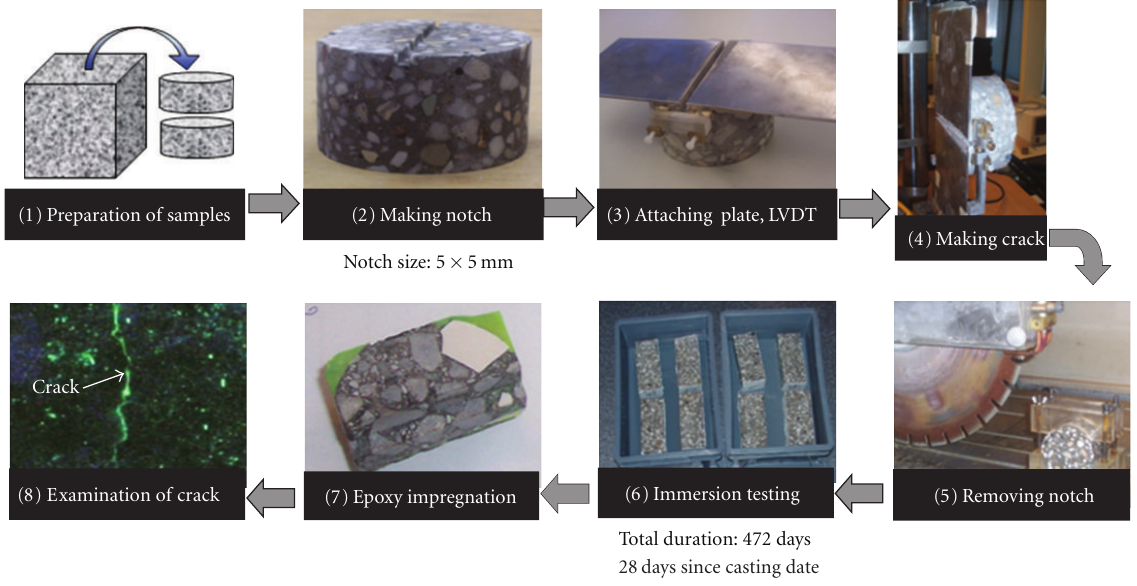
Figure 1: Outline of experimental procedures: from making concrete samples to getting data.